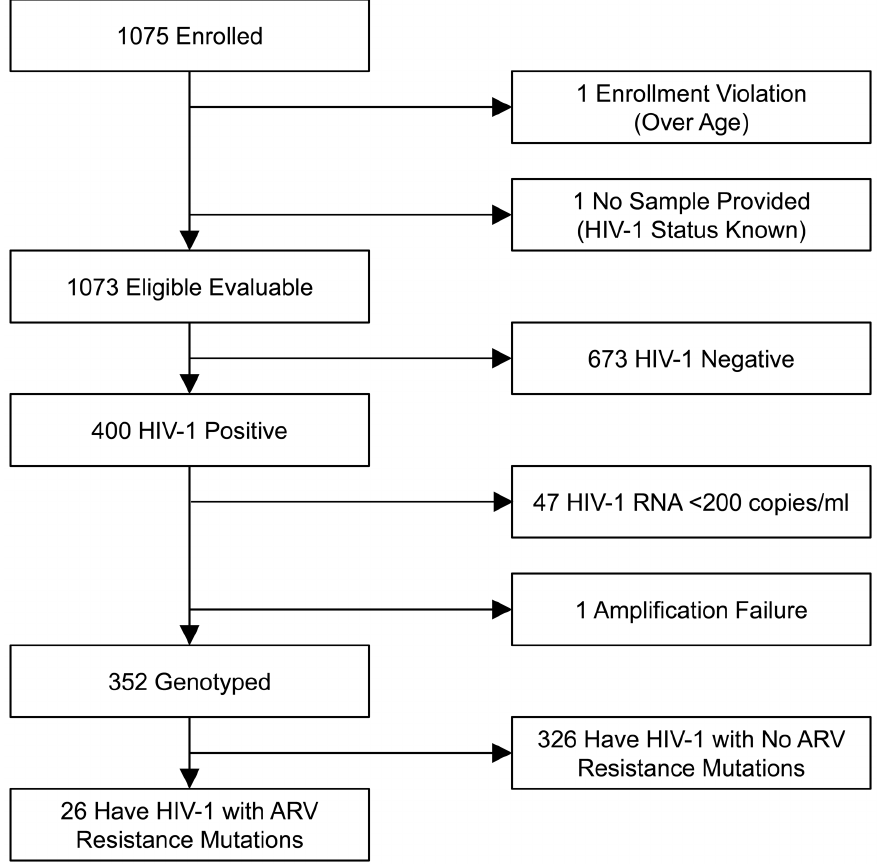
Figure 2. Consort Diagram. doi:10.1371/journal.pone.0059787.g002 PLOS ONE |